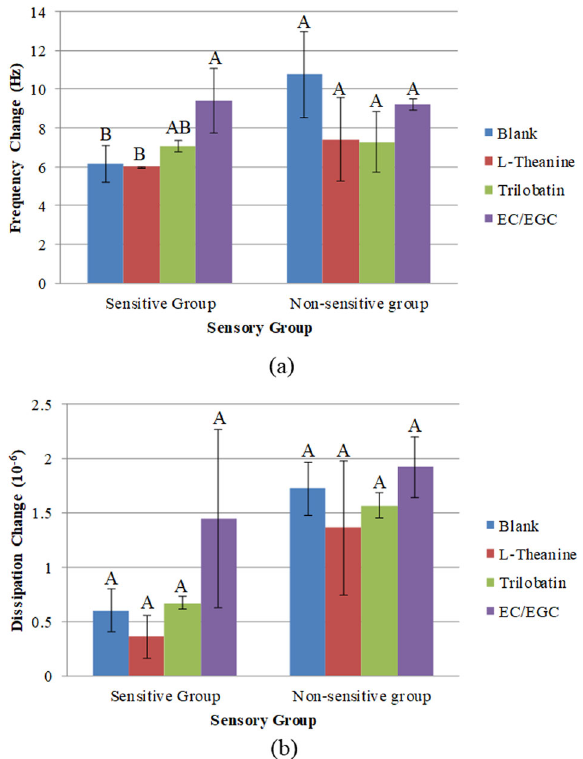
Fig. 6 The change of frequency and dissipation after stabilization of the saliva-sample layer by a buffer rinse. a , b Frequency and dissipation, respectively. Means without the same letter indicate signi fi cant difference in the particular sensory group. The error bars represent 95% con fi dence